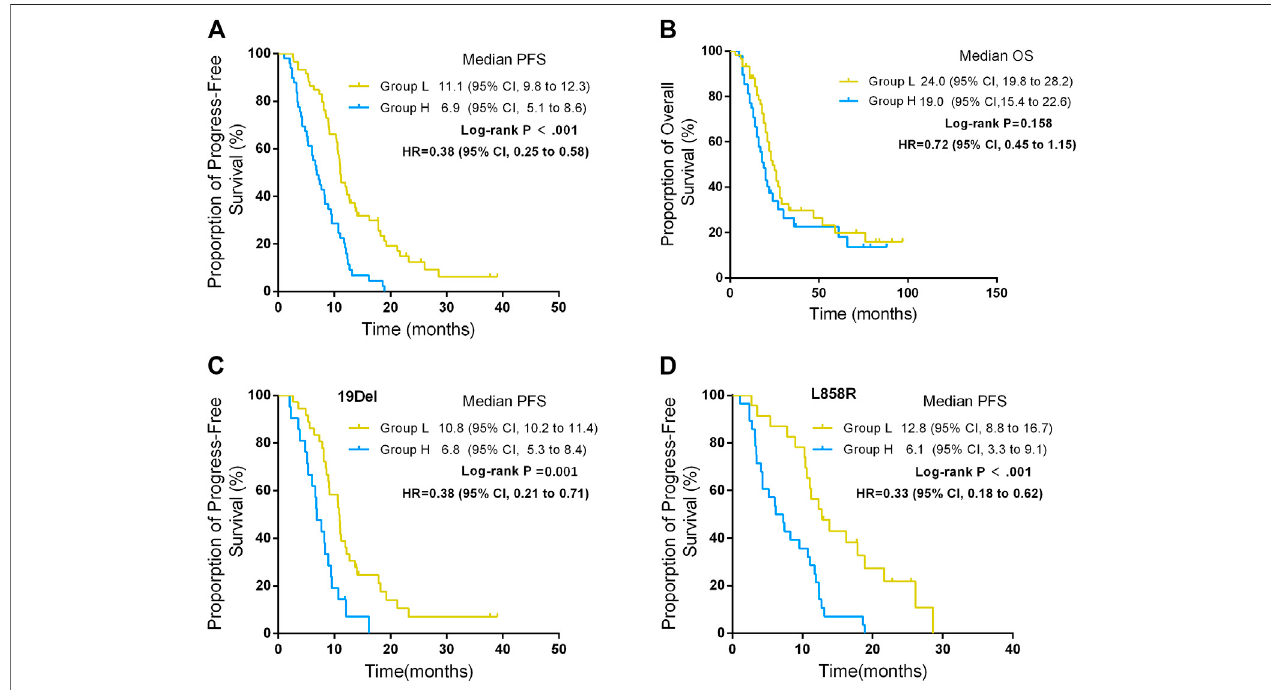
FIGURE 2 | Progression-free survival (PFS) and overall survival (OS) between different Δ CT value groups. (A) PFS between different Δ CT value groups. (B) OS between different Δ CT value groups. (C) PFS between different Δ CT value groups in patients harboring EGFR 19Del. (D) PFS between different Δ CT value groups in patients harboring EGFR L858R.